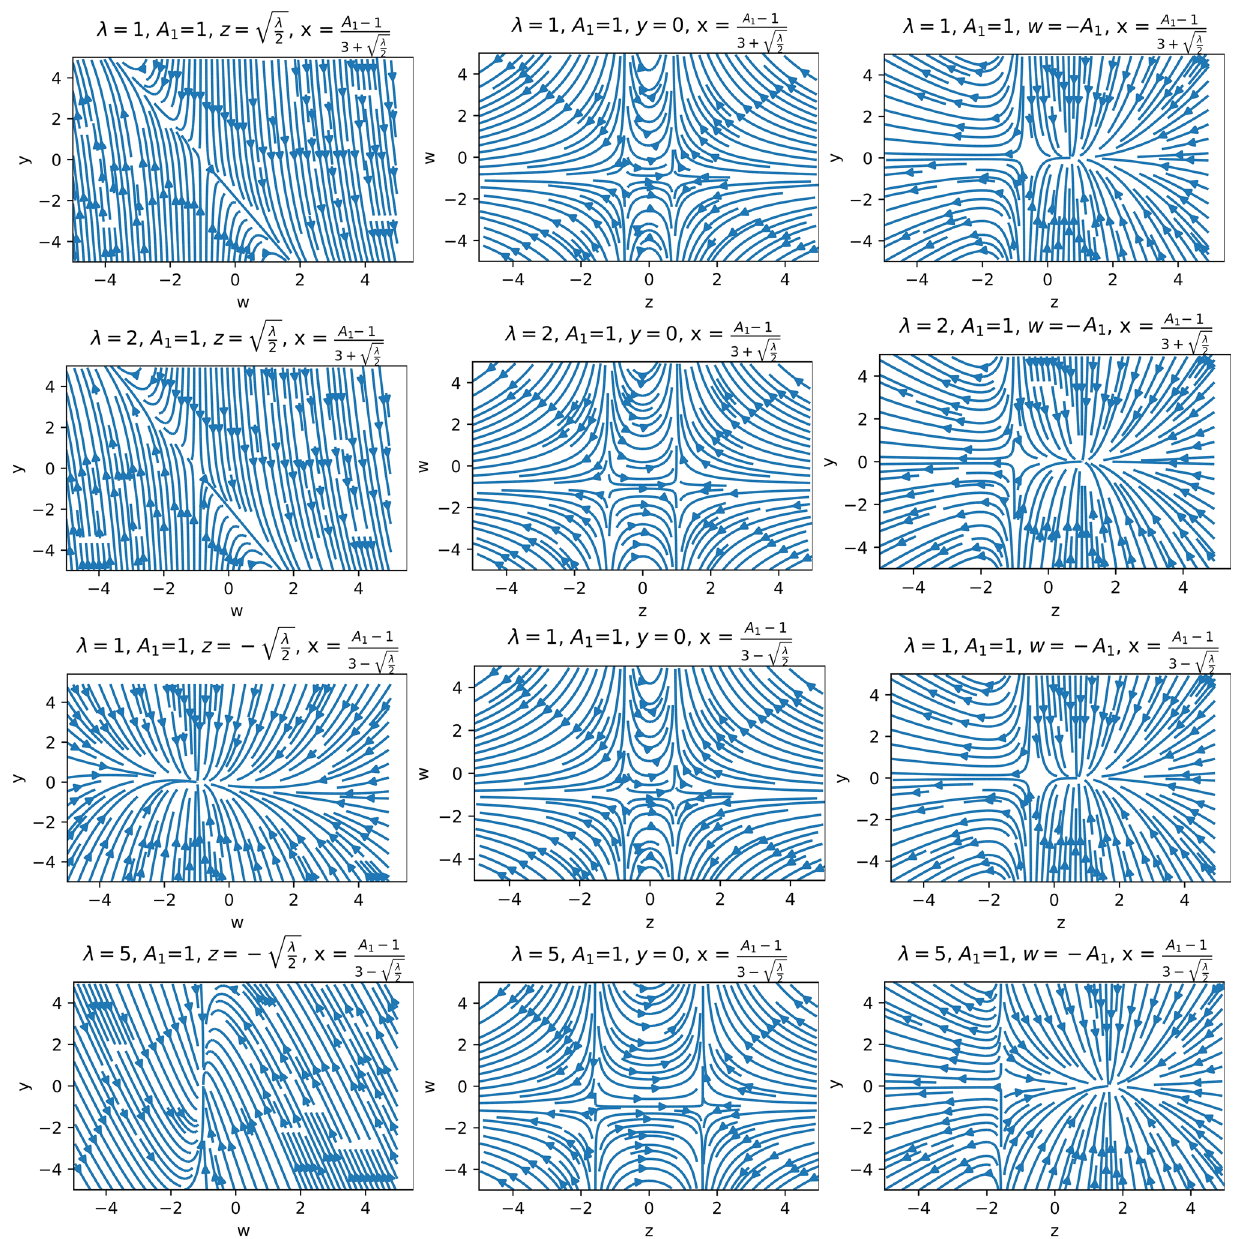
Fig. 1 Different views of the phase space of the dynamical system in Eq. (32) for λ (cid:2)= 0. The system was reduced to a 2-d surface represent- ing the different perspectives of its constraint. The arrows represent the